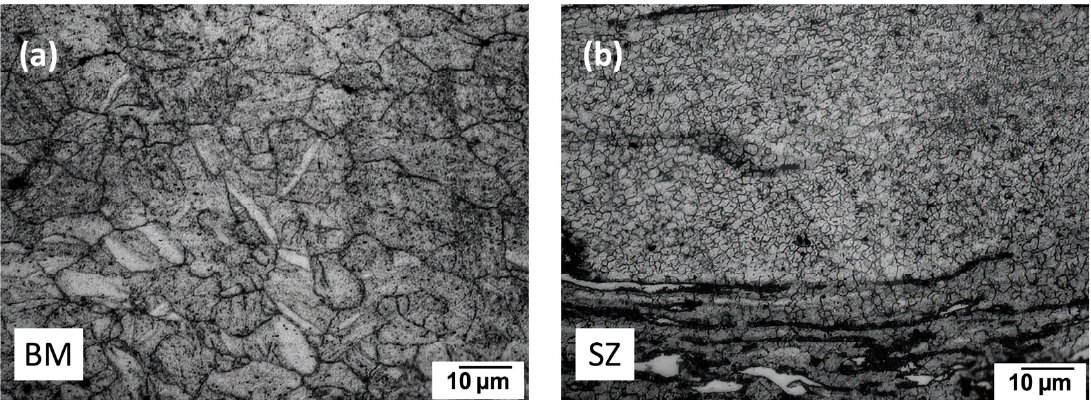
Figure 5. Optical microscopic pictures of a grain structure on etched 6022 Al from a cross-sectional perspective: ( a ) Stirred zone; ( b ) thermomechanically affected zone; ( c ) heat-affected zone; ( d ) base 6022 Al.